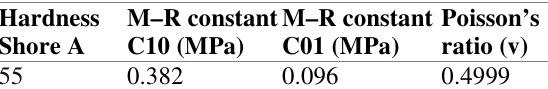
Mechanical properties of Polyurethane rubber